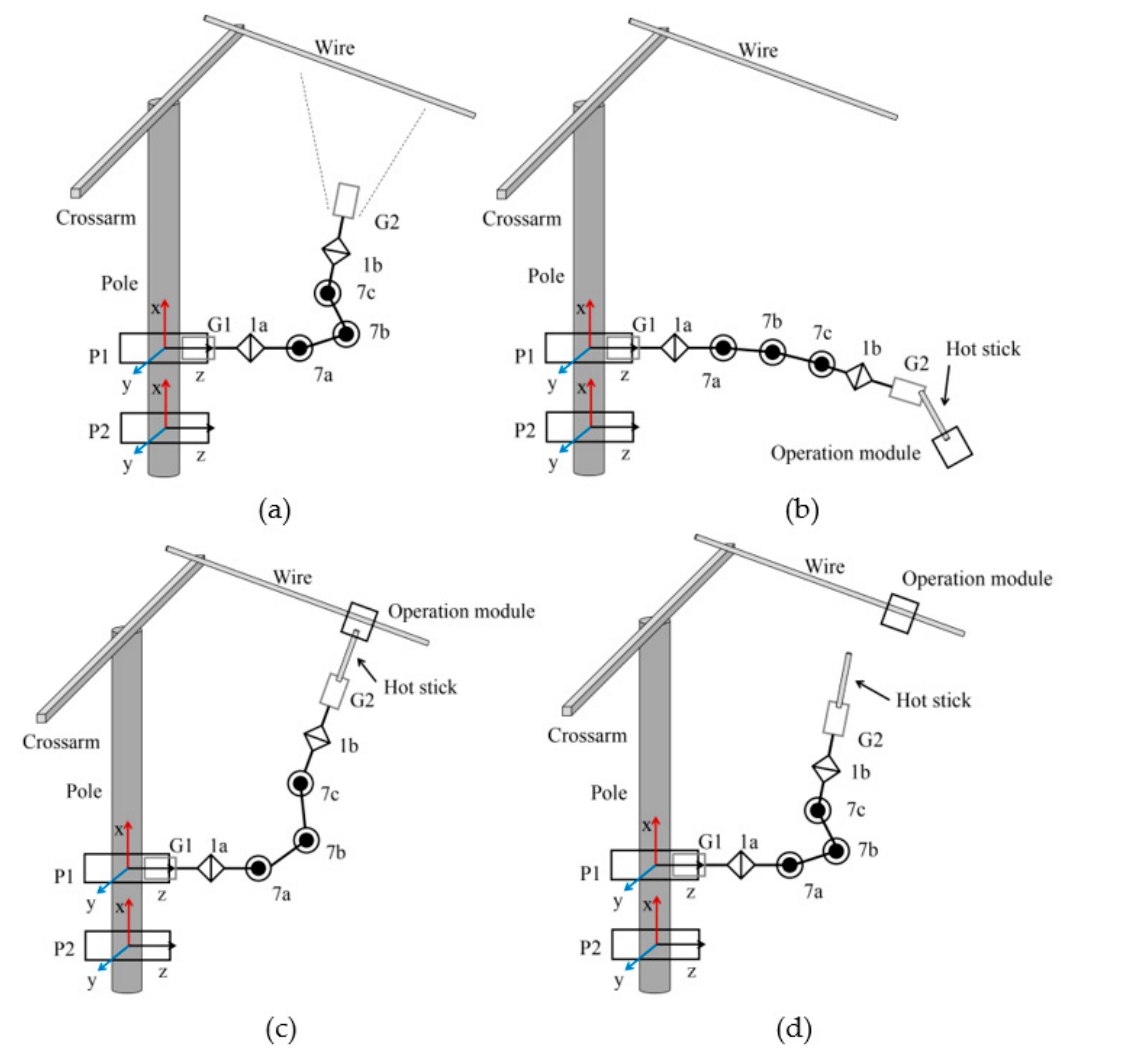
Figure 22. Operation motion. ( a ) aiming, ( b ) grasping, ( c ) touching, ( d ) releasing.